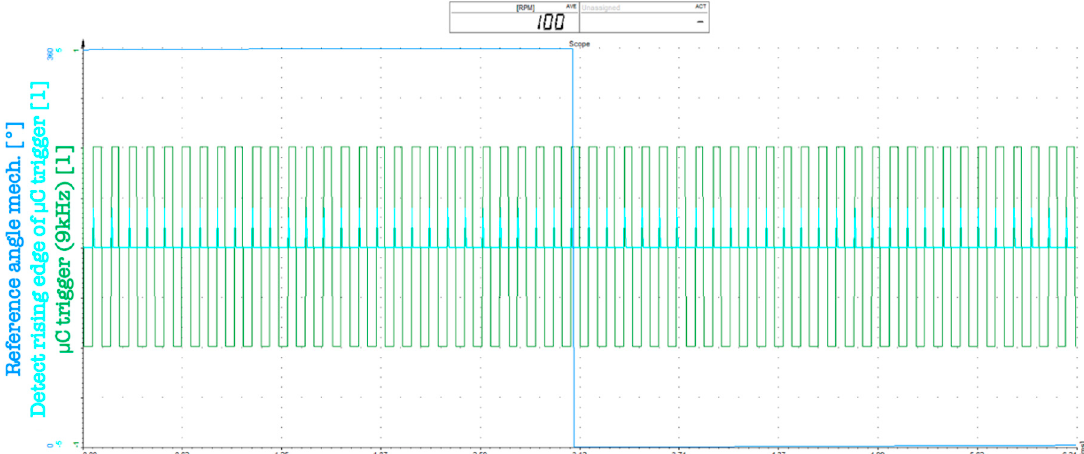
Figure 16. Scope image of the triggered reference sensor acquisition at a constant speed of n = 100 rpm, capturing the mechanical reference angular position (blue), the μ C trigger with a frequency of f μ C Trigger = 9 kHz (green) and the rising edge of the trigger signal (cyan), detected by the reference acquisition FPGA.